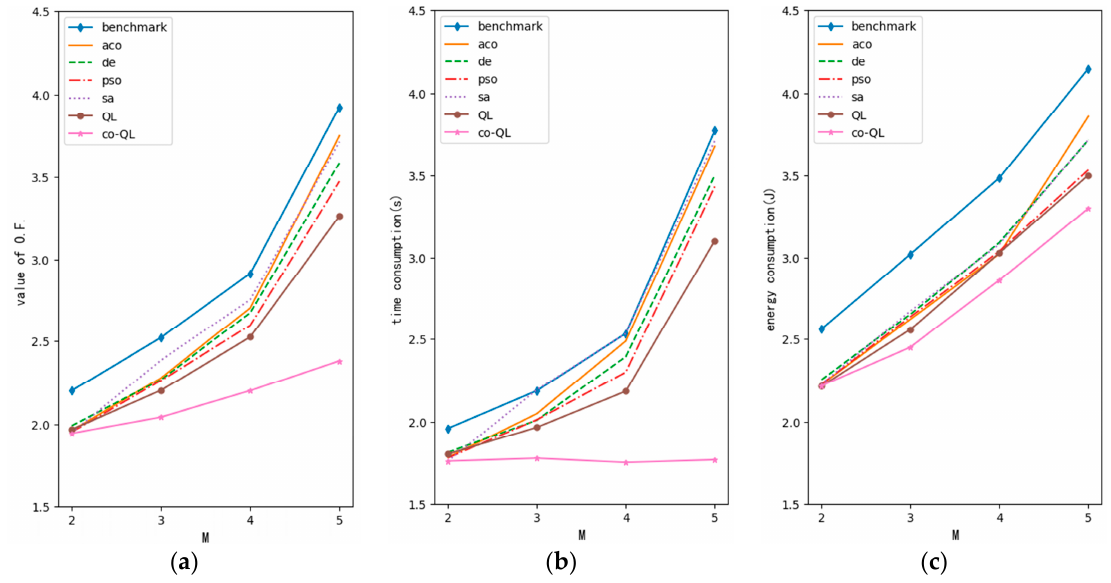
Figure 7. Optimization performance curve with variable M (N = 5, G = 1): ( a ) curve for value of objective function; ( b ) curve for time consumption; ( c ) curve for energy consumption.